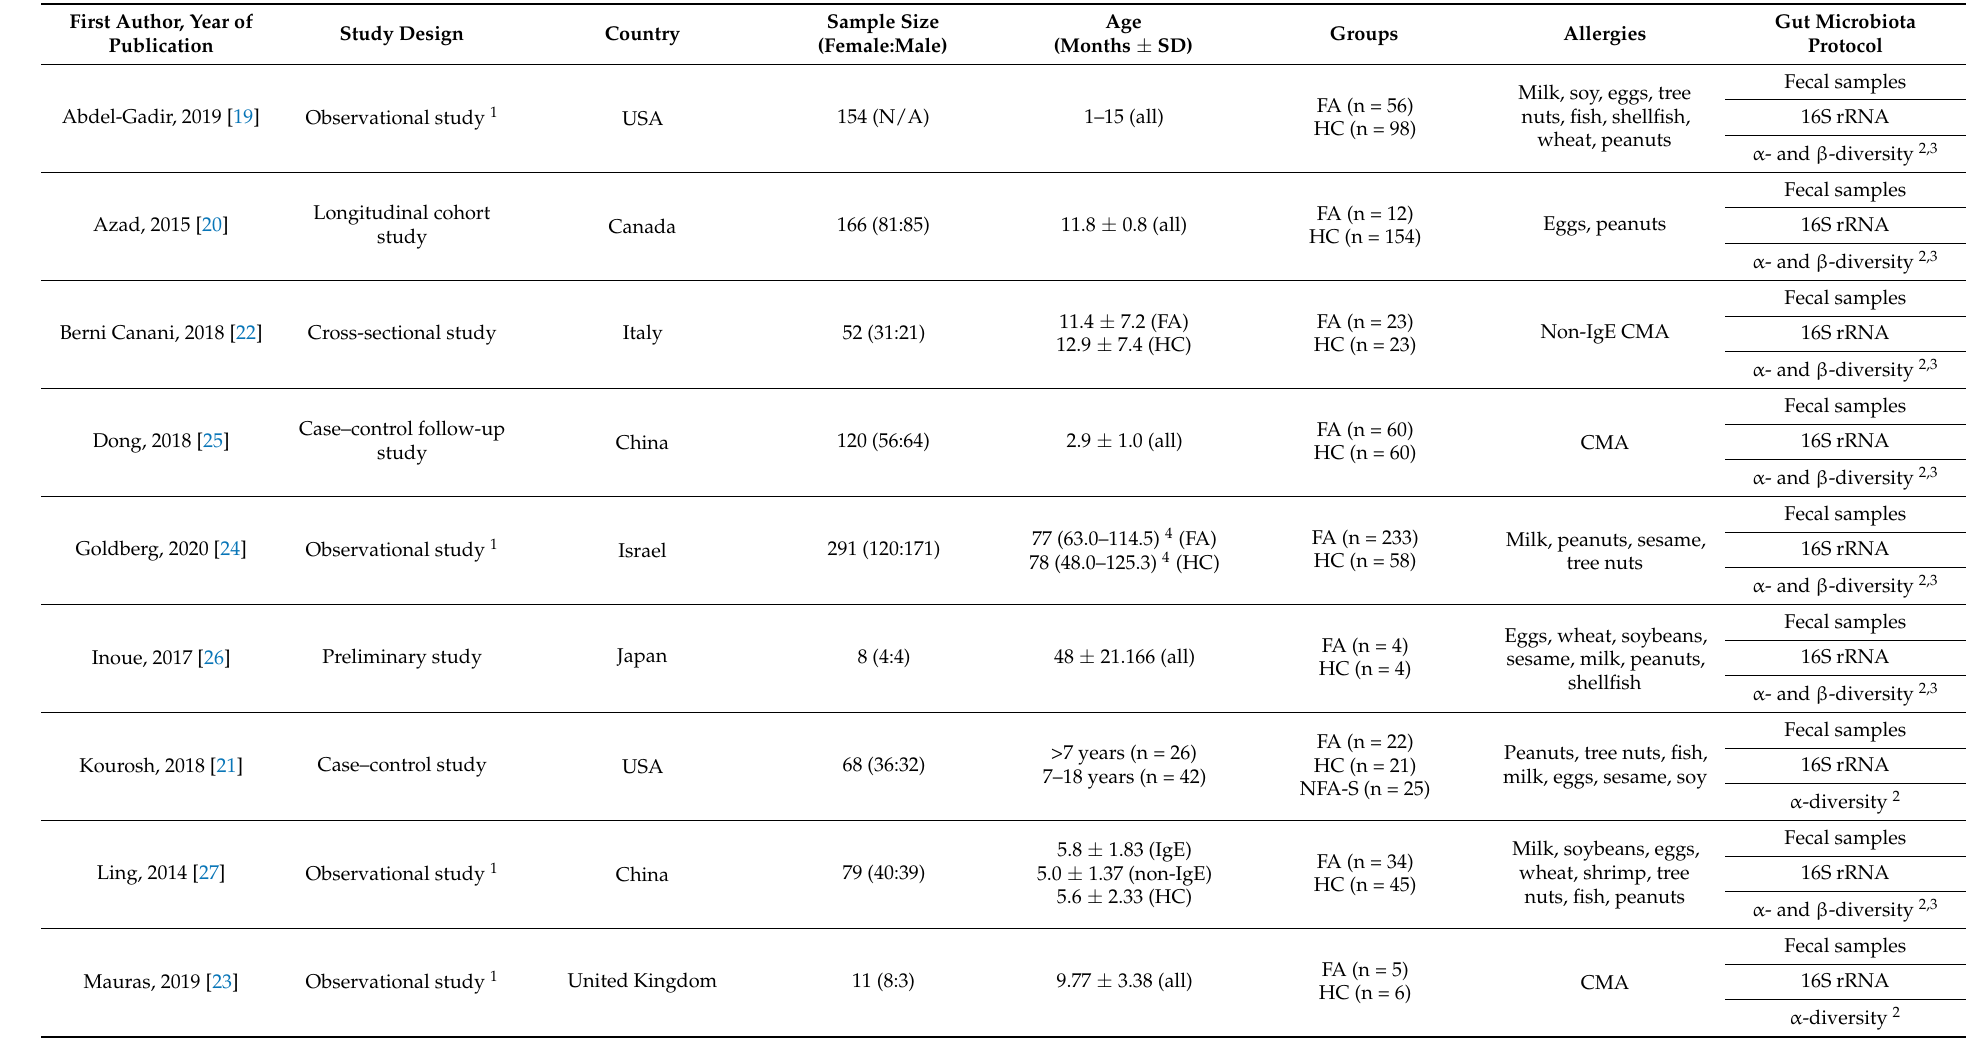
Table 2. Characteristics of the studies exploring gut microbiota in individuals with food allergies vs. healthy